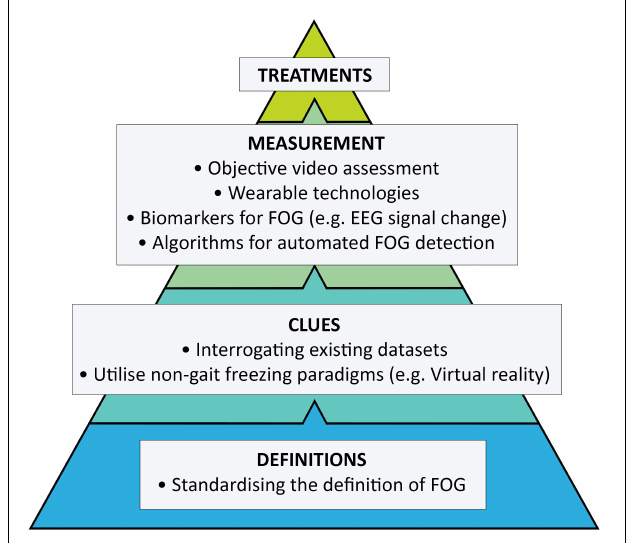
FIGURE 1 | Key steps toward developing effective therapies for freezing of